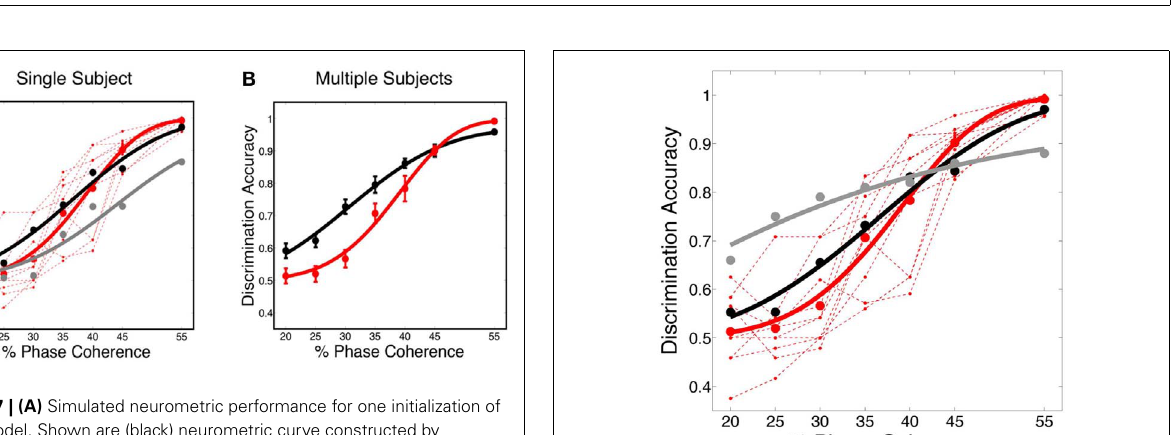
FIGURE 6 | (A) Spike trains from simulated neurons are aligned relative to stimulus onset.Words are constructed by binning spike trains using a given temporal bin width. (B) A spatio-temporal word represented as a matrix of